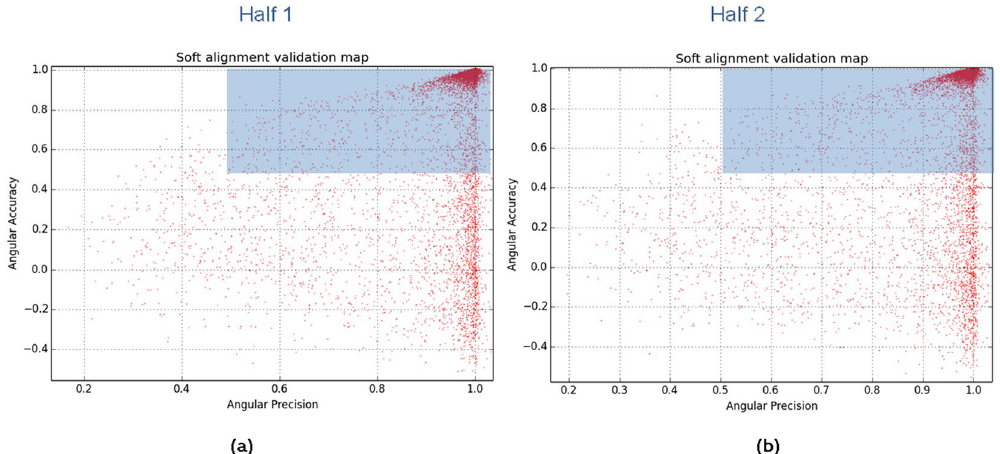
Figure 5. Soft-alignment validation maps for each half of the β -galactosidase complex and composed by 11,412 particles. The blue partially transparent rectangle indicates the particles which align with both accuracy and precision.